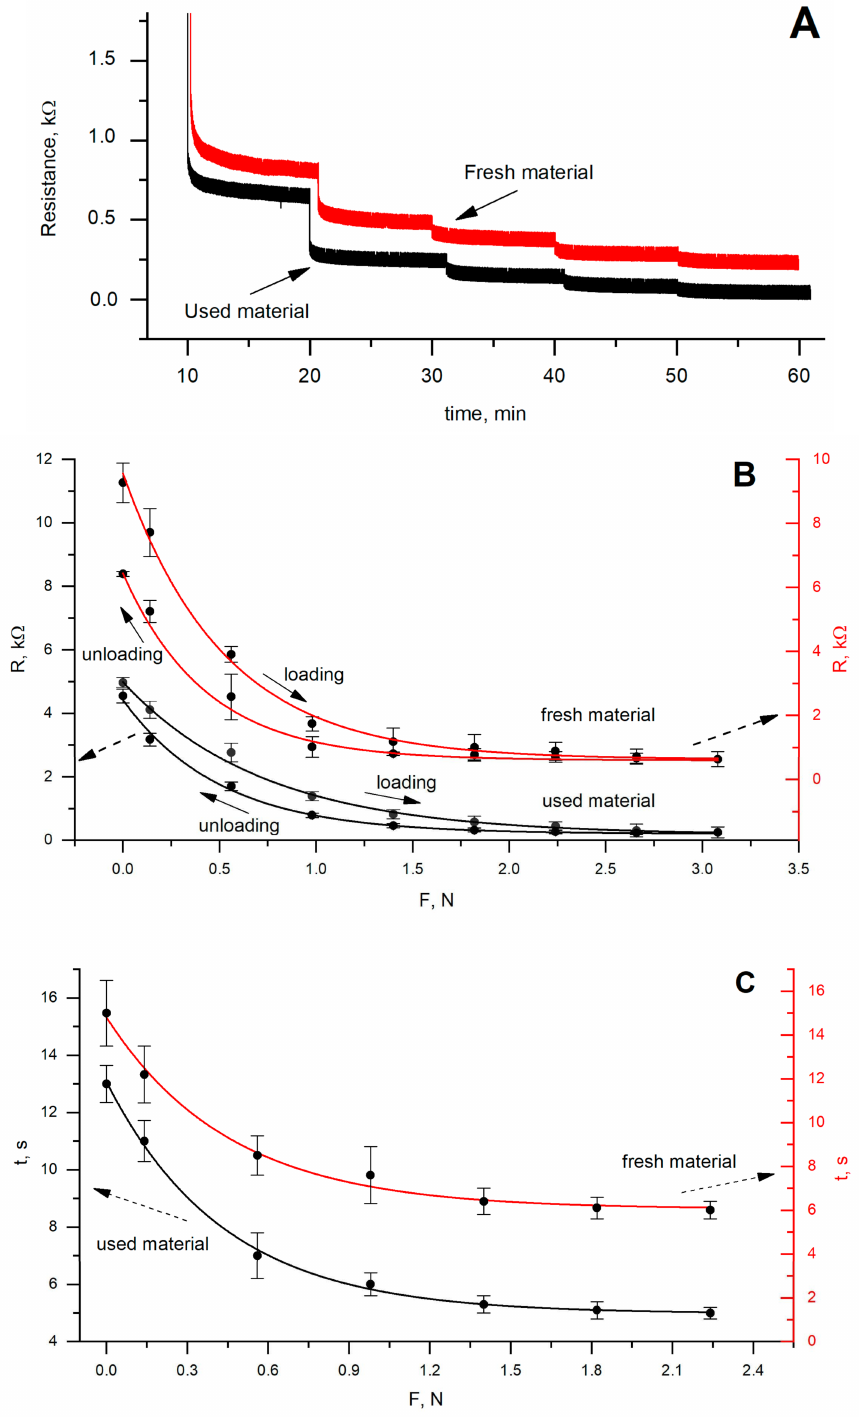
Figure 5. ( A ) Resistance dependence on time. Material was pressed with a force of 0.14 to 3.08 N with an increment of 0.42 N. The force was further increased every 8 min. ( B ) Dependencies between the load and the resistance of a used and fresh material. ( C ) The response time of used and fresh Velostat ® -based